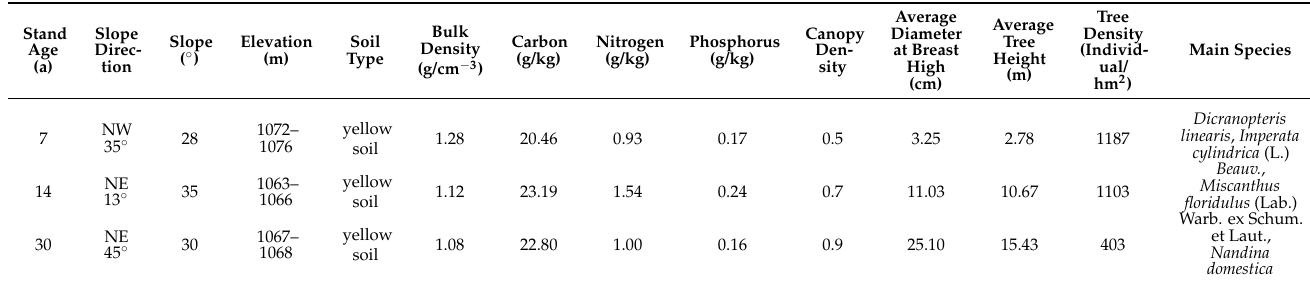
Table 1. Basic information of sampling plots in Masson pine